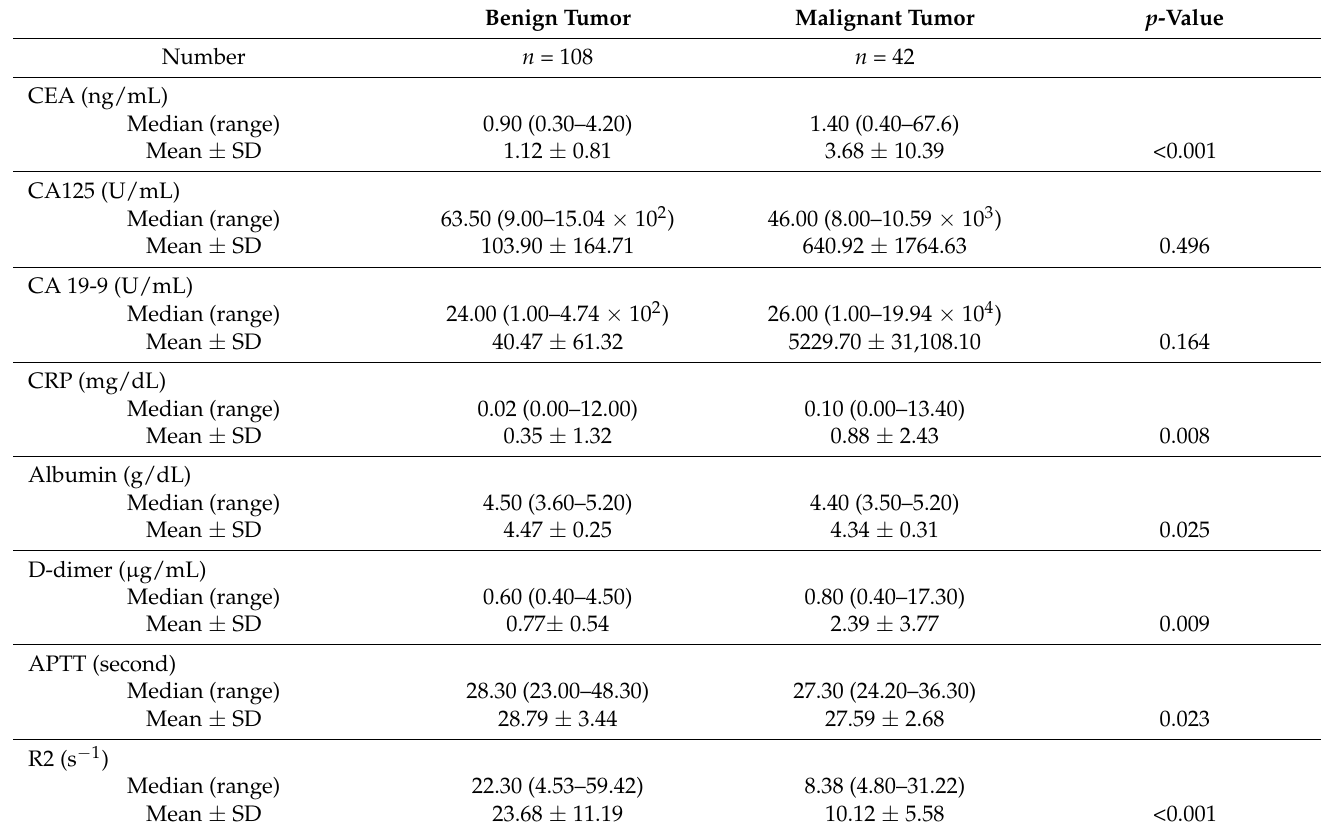
Table 3. Serum markers and blood coagulation examination in peripheral blood cells and R2 value obtained by MR relaxometry. Benign Tumor Malignant Tumor p -Value